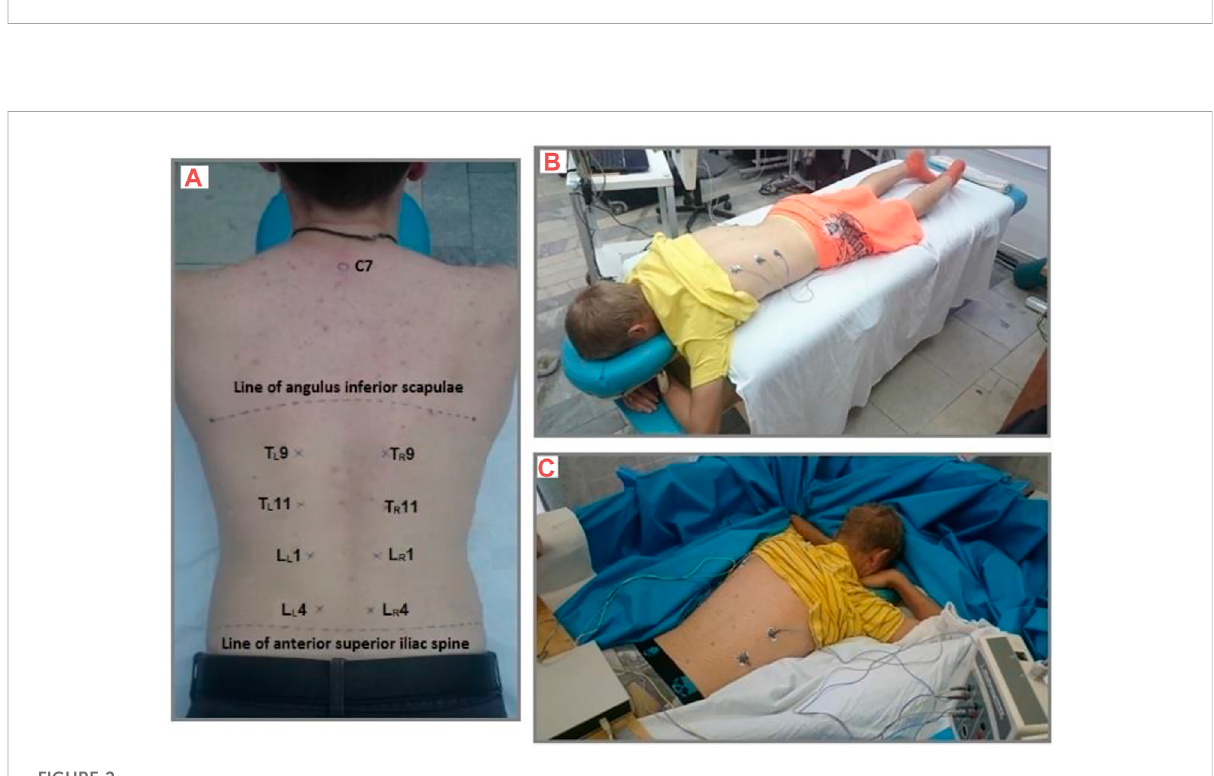
FIGURE 2 Measurement of Lower Lumbar (LL4, LR4), Upper Lumbar (LL1, LR1), Lower Thoracic (TL11, TR11), and Middle Thoracic (TL9, TR9) locations. (A) Subject remained prone for lumbar and thoracic trunk myofascial tissue assessment (B) on a couch, and (C) in the DI